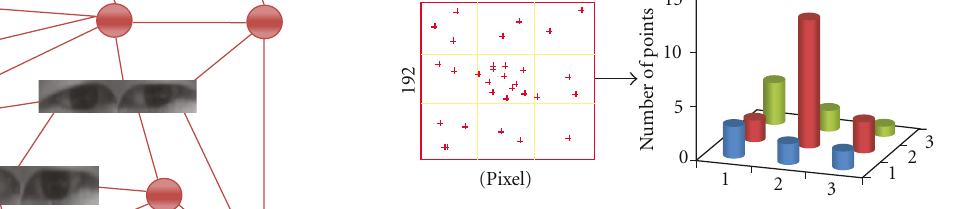
Figure 10: Left red rectangle is 256 × 192 pixels whose center is (640, 480) of the monitor coordinate. Right histogram is a statistical result on 9 subregions (small yellow